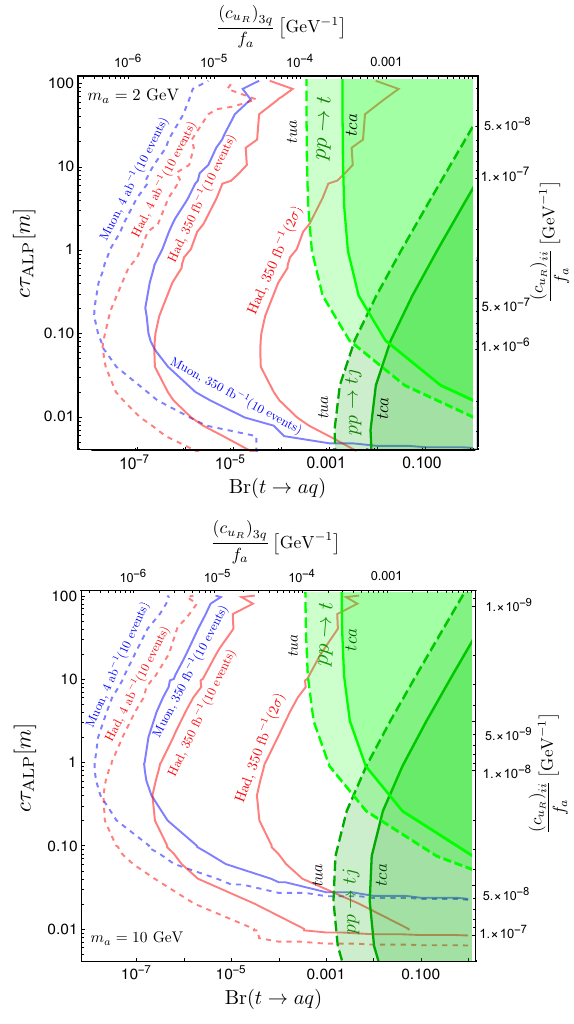
Figure 7 . The same figure as figure 6, where the expected 10 events lines at the HL-LHC with √ s = 14 TeV, and L = 4 ab − 1 integrated luminosity is shown in dashed lines. The red dashed line represents an ALP that decays within the hadronic calorimeter and the dashed blue is when the ALP decays in within the muon